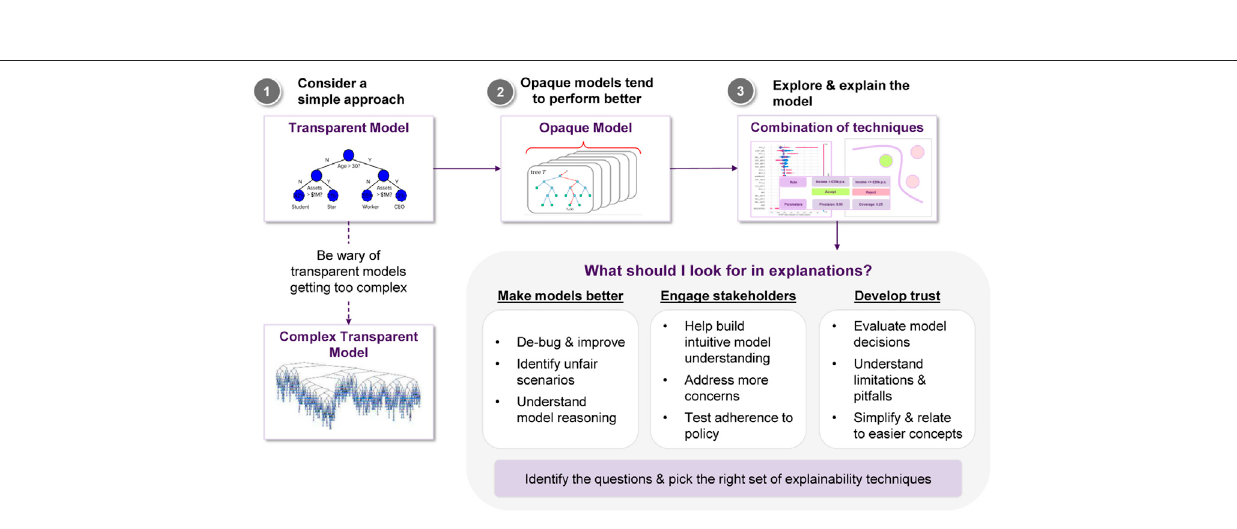
Frontiers in Big Data |